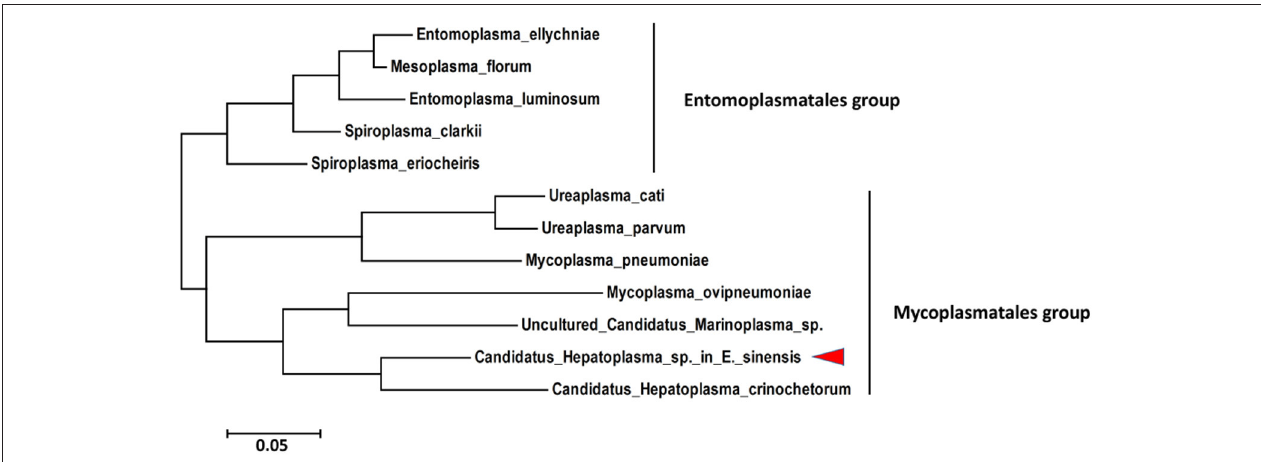
FIGURE 6 | Phylogenetic tree based on the 16S rRNA gene sequence showing the relationship between Candidatus Hepatopancreas and Tenericutes.